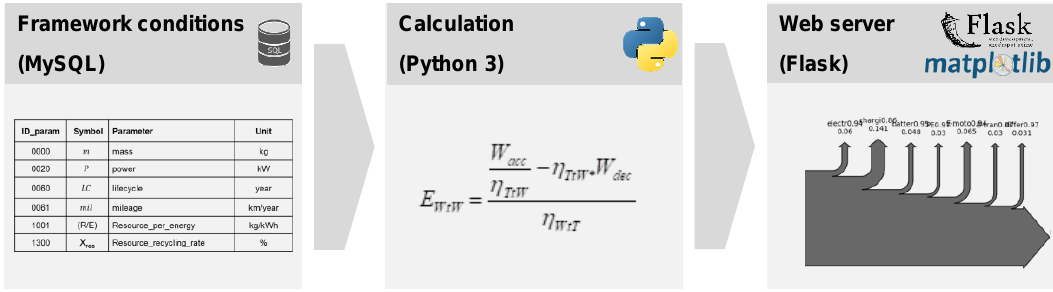
Figure 5. Implementation architecture.